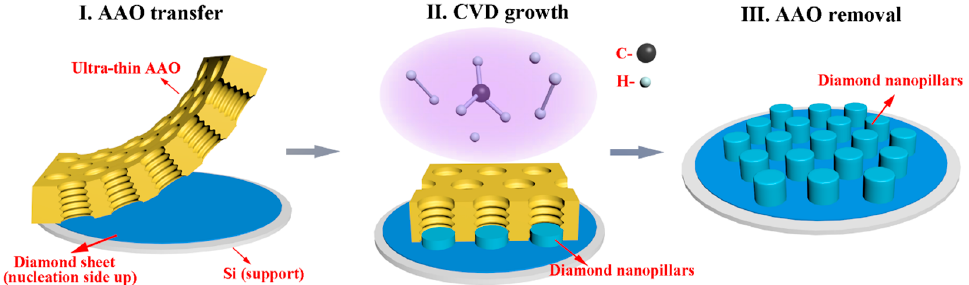
Figure 1. Schematic diagram of the fabricating process of diamond nanopillar arrays by using AAO templates.